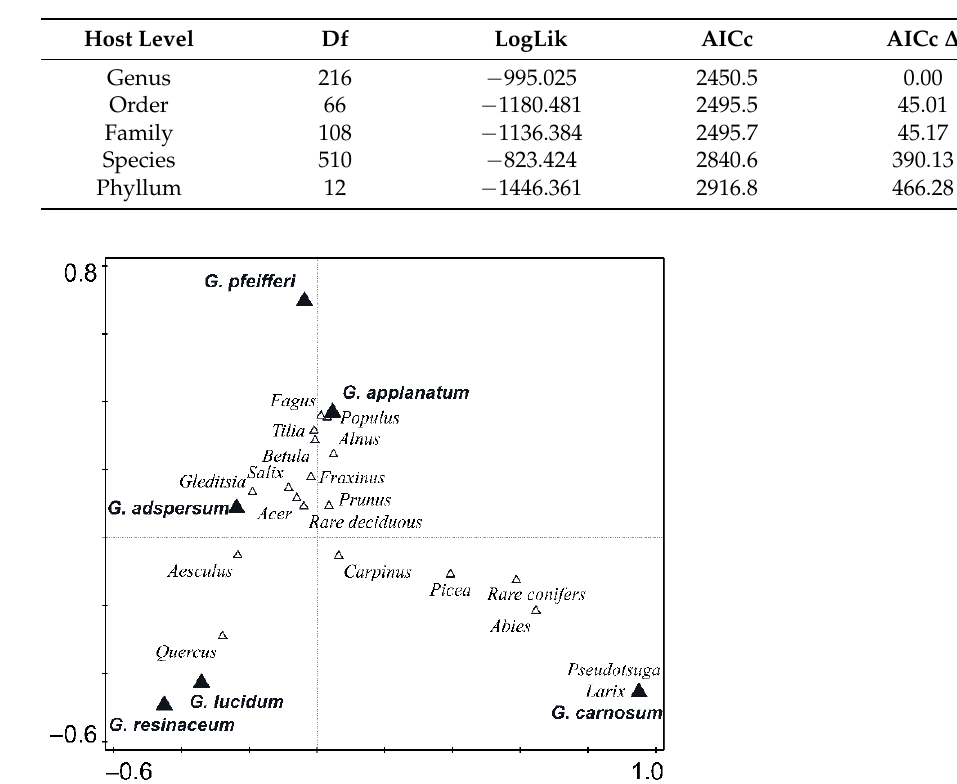
Figure 4. CCA analysis plot showing the differences in host tree composition among Ganoderma species and affiliation of them to host genera.